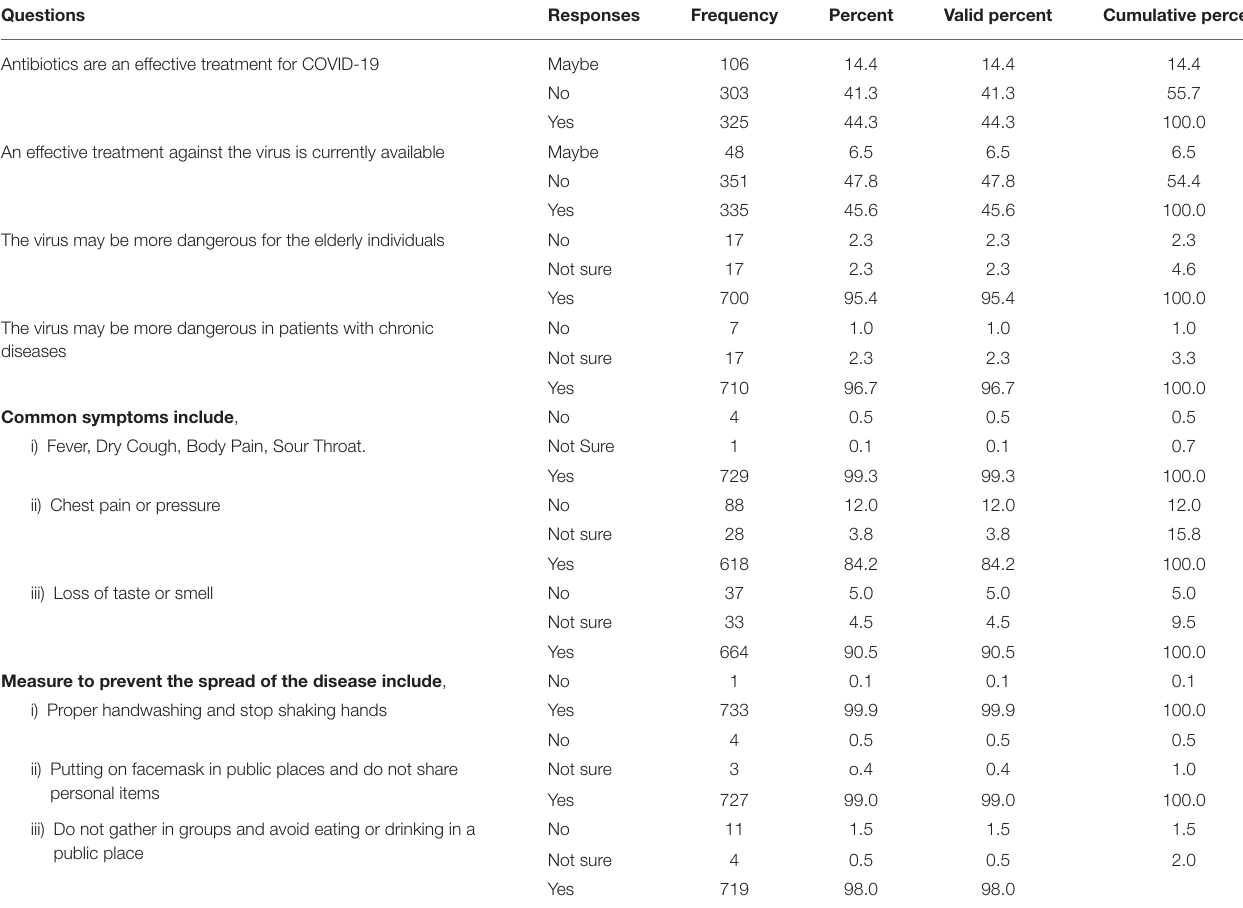
TABLE 2 | Participant knowledge of COVID-19 ( N =